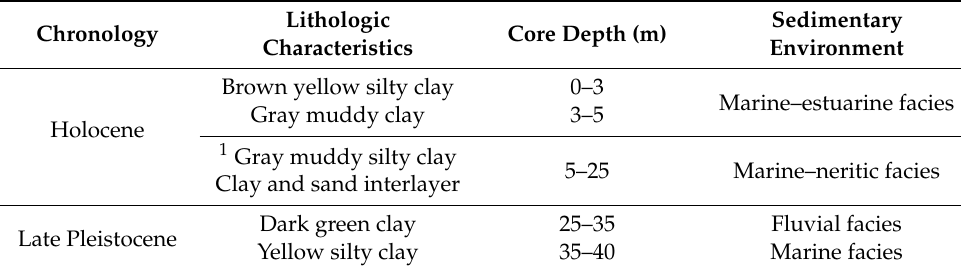
Figure 1. Sampling location of the soft soils. Table 1. Geological conditions for